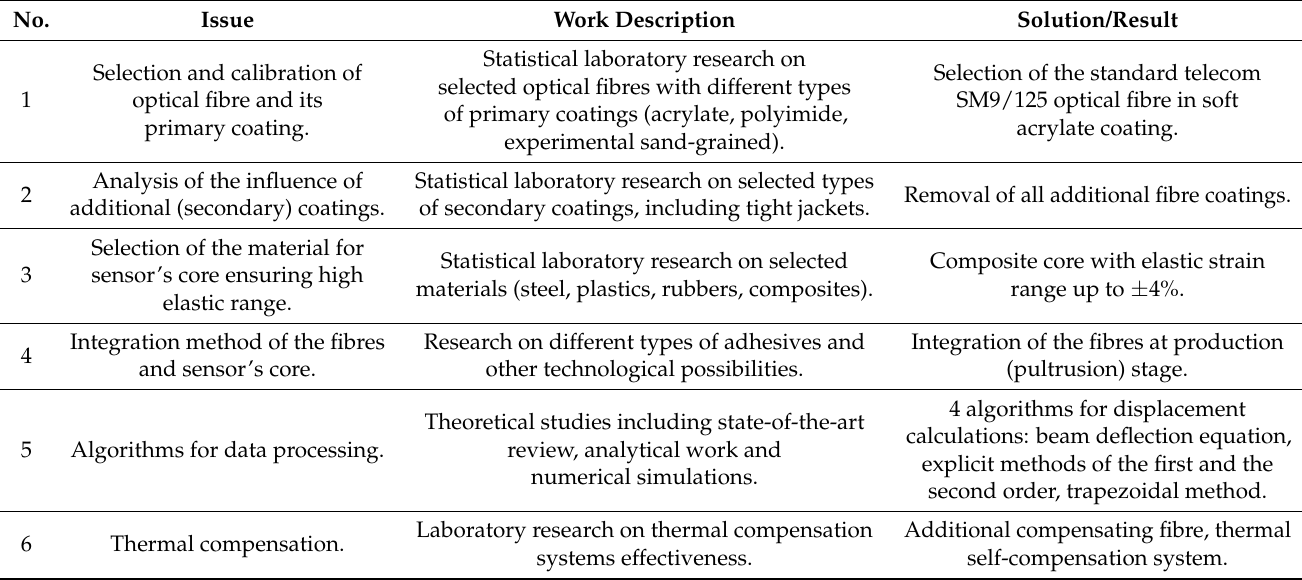
Table 1. Issues addressed during the development of new distributed fibre optic displacement